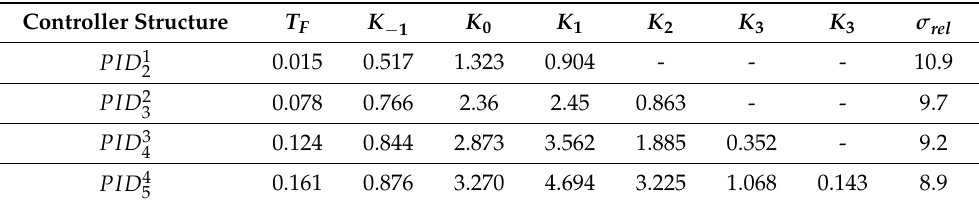
Table 5. The calculated filter time constants T F and controller parameters at different controller order m ( n = m +